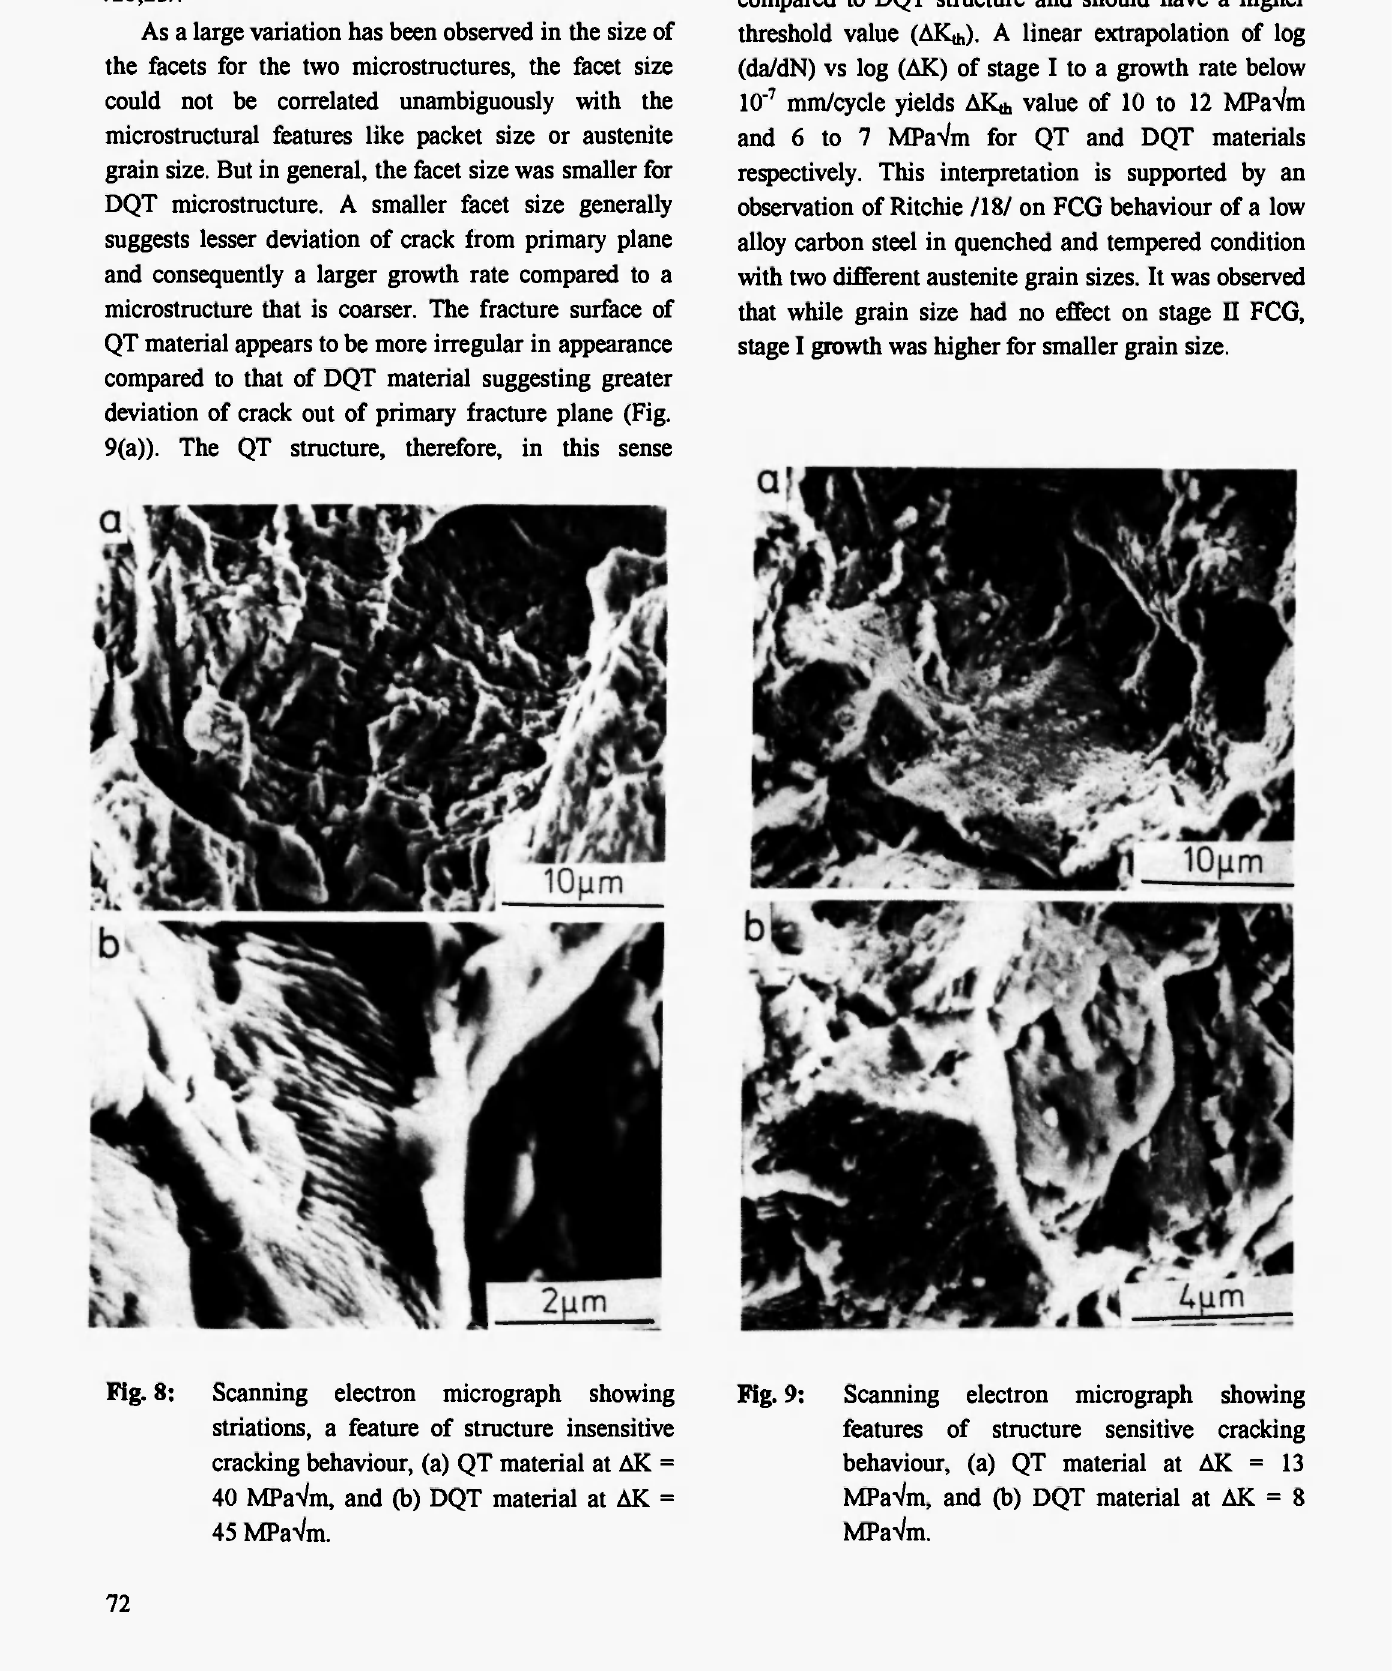
Fig. 8: Scanning electron micrograph showing striations, a feature of structure insensitive cracking behaviour, (a) QT material at ΔΚ = 40 MPaVm, and (b) DQT material at ΔΚ = 45 MPaVm.